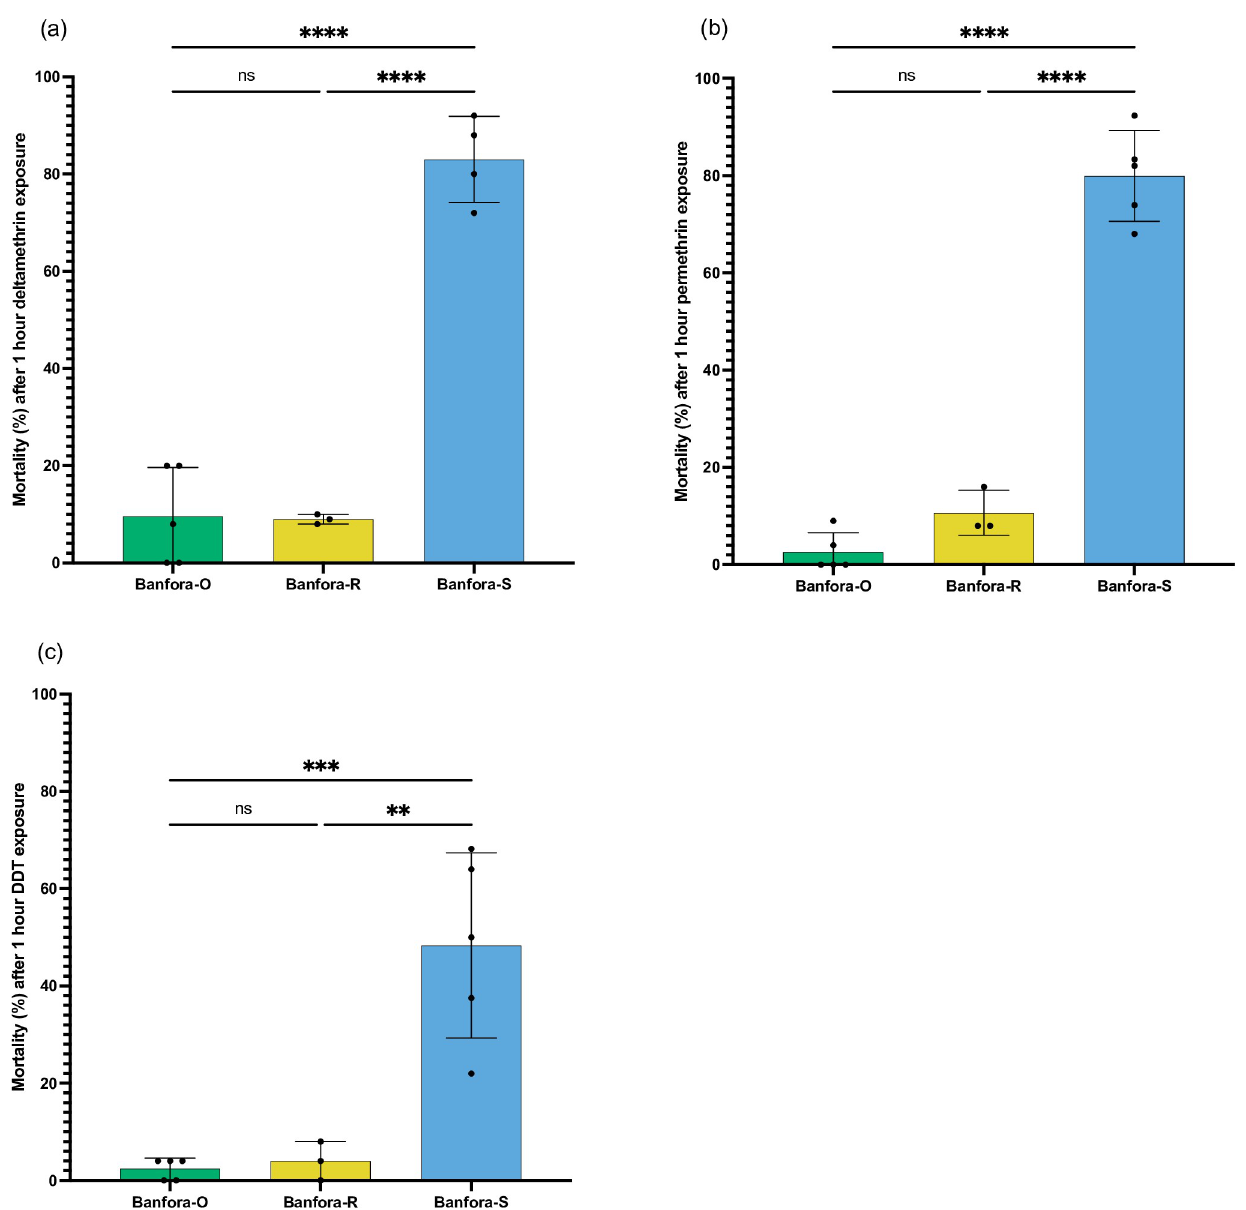
Fig 1. Phenotyping of three Banfora lines. 24-hour mortality after standard WHO assays for (a) 0.05% deltamethrin, (b) 0.75% permethrin and (c) 4% DDT. The Banfora-O population mortality is taken from phenotyping 6-months before loss of resistance, both Banfora-S and Banfora-R colony phenotypes are shown. Significant difference calculated by ANOVA followed by Tukey’s ad hoc test. ���� p < 0.0001 and �� p <